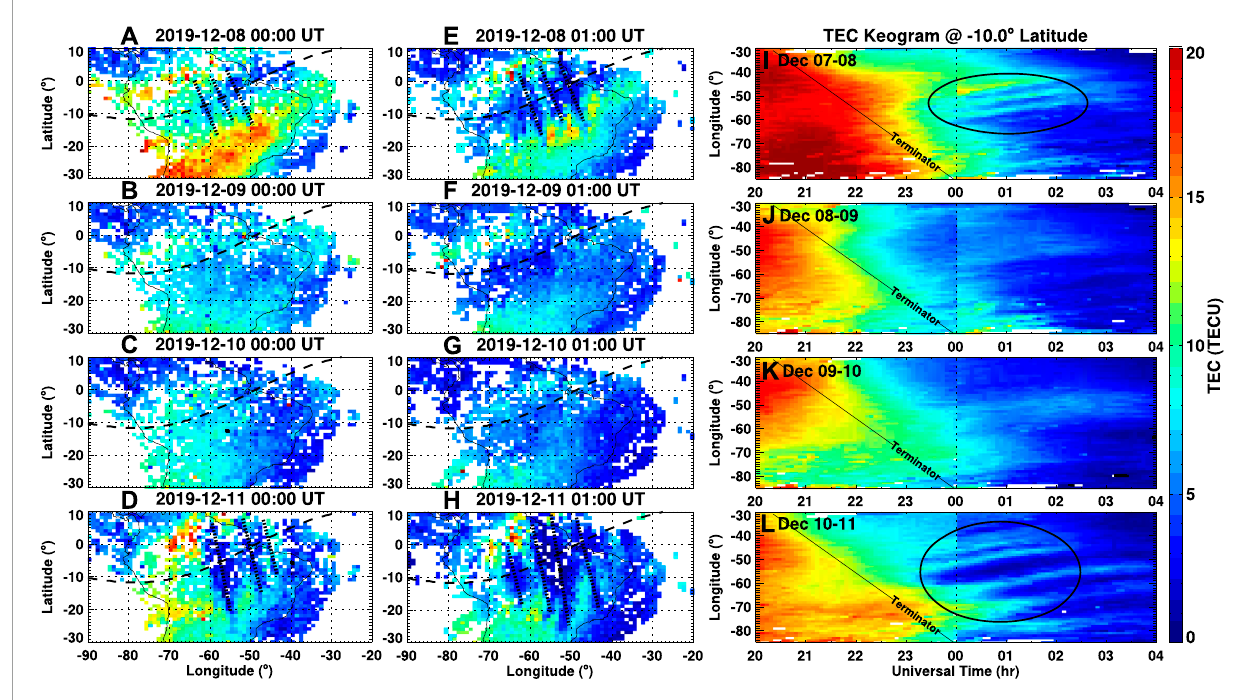
FIGURE 3 (A–H) Gridded TEC maps over the South American area at 00 and 01 UT on 08–11 December 2019, respectively. The geomagnetic equator is marked with a dashed line. The quasi-parallel dotted lines marked strong EPBs. (I–L) TEC keogram as a function of time and longitude along −10 ° latitude during 07–11 December 2019, respectively. The sunset terminator is marked, and ovals mark strong